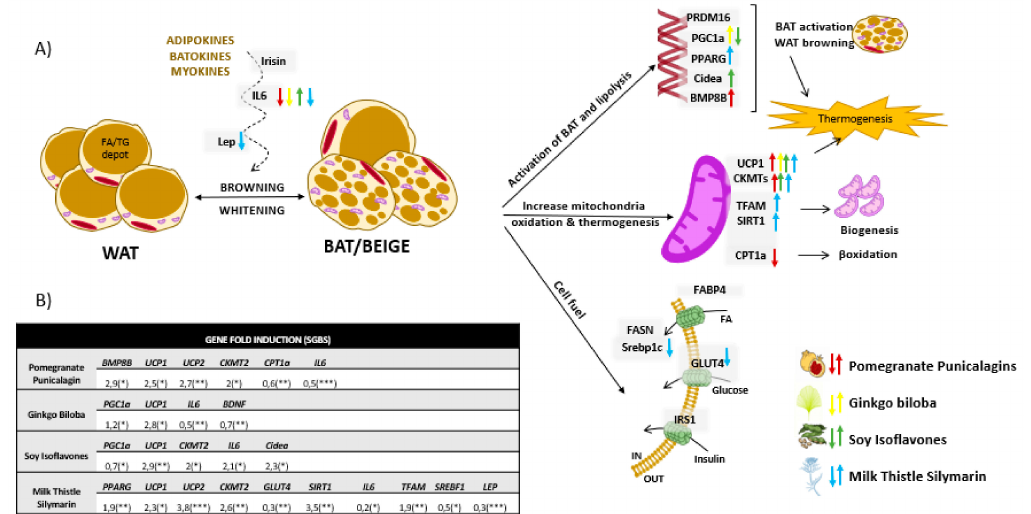
Figure 4. ( A ) Graphical representation of genes modulated by the extracts in differentiated human adipocytes SGBS compared to no-treated cells. Up or down arrows indicate upregulation or dow-regulation in gene expression after treatment with the extracts. Statistically significant genes whose expression was modulated in differentiated human adipocytes SGBS after 48h of treatment with the extracts, compared to no-treated cells. ( B ) Mean fold induction of at least 3 independent experiments are shown. Asterisks indicate significant statistic differences * < 0.01, ** < 0.005, *** <